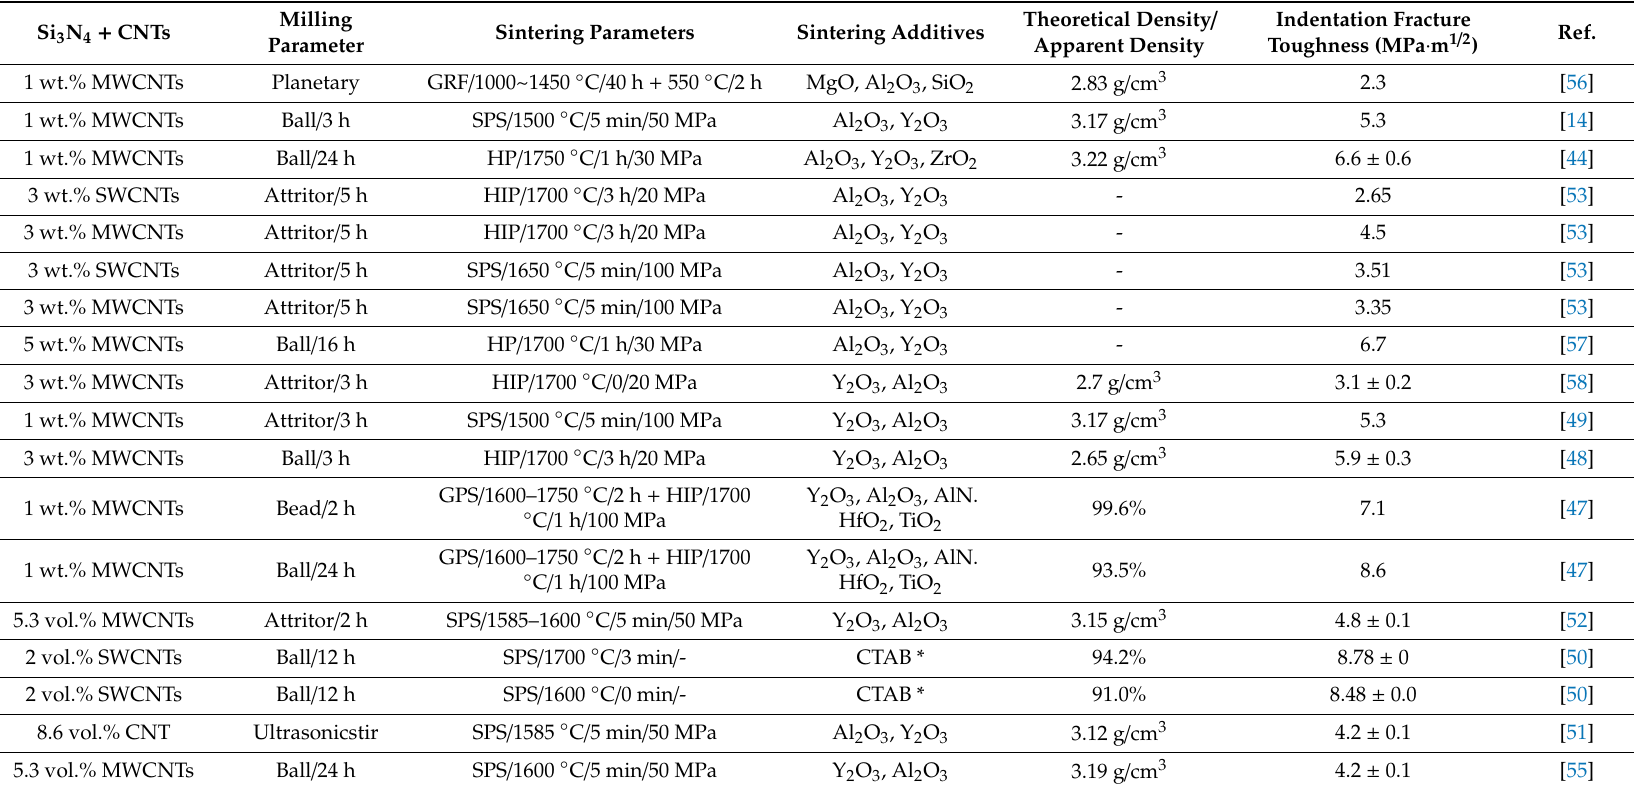
Table 4. Fracture toughness of CNT-reinforced silicon nitride composites reported by di ff erent